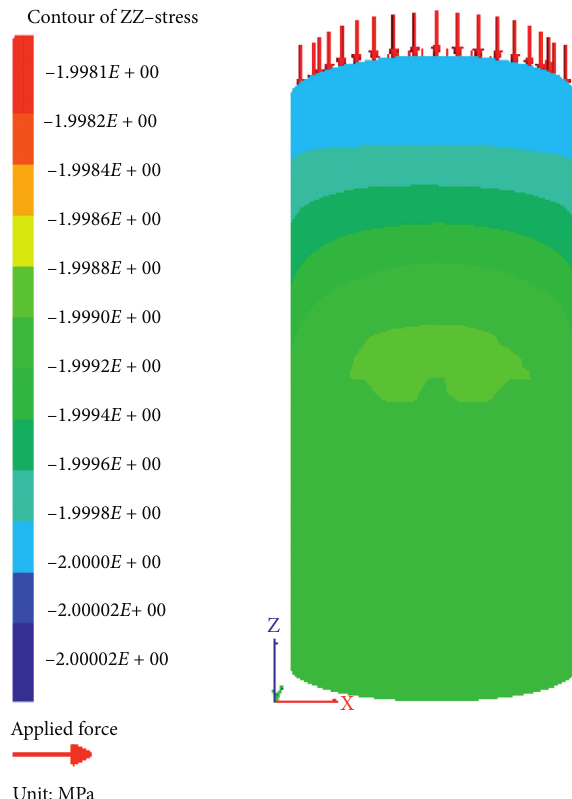
Figure 5: Normal stress distribution in the sample.